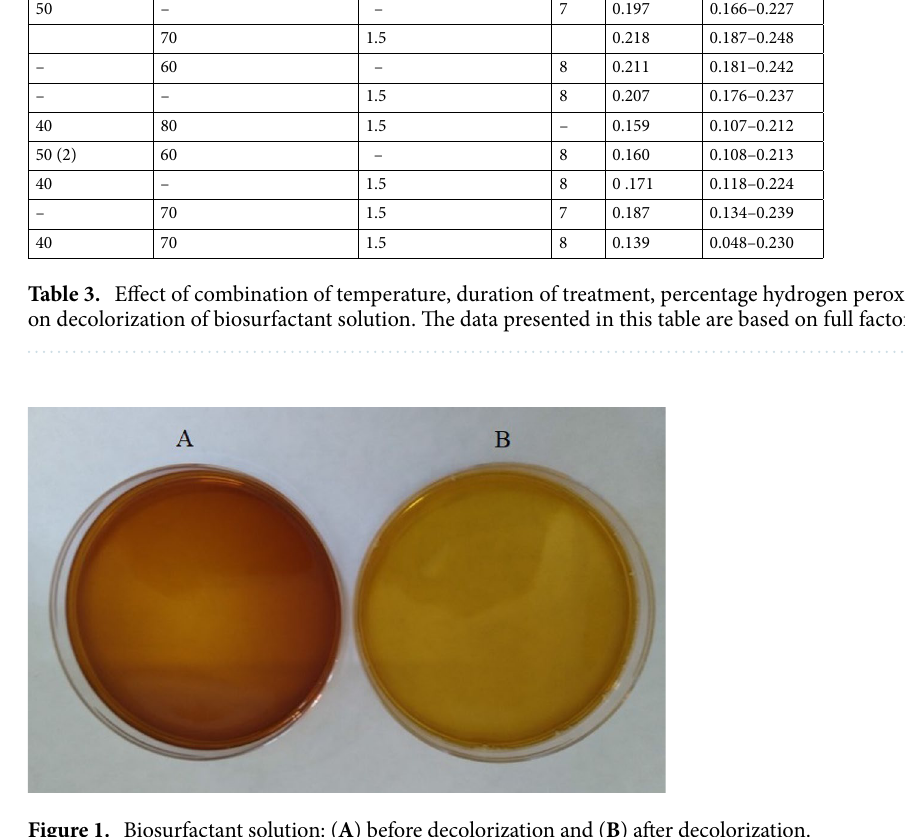
Figure 1. Biosurfactant solution: ( A ) before decolorization and ( B ) after